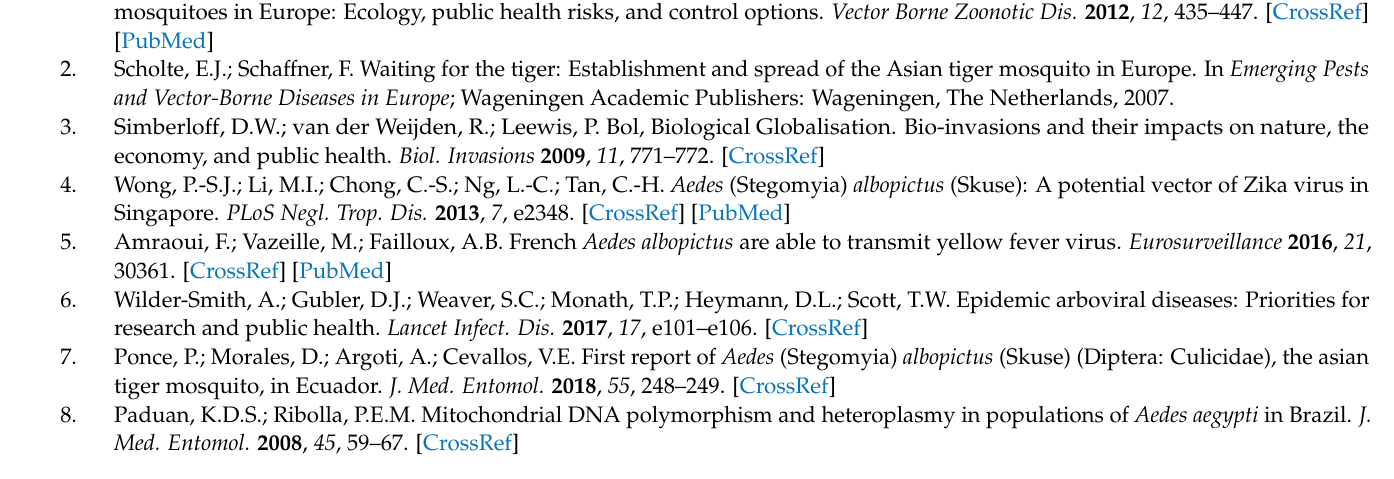
S1: Triangular plot produced by the structure, showing only one genetic cluster in the Ecuadorian populations of Aedes albopictus , Figure S2: Bar plot produced by the structure, showing only one genetic cluster in the Ecuadorian populations of Aedes albopictus